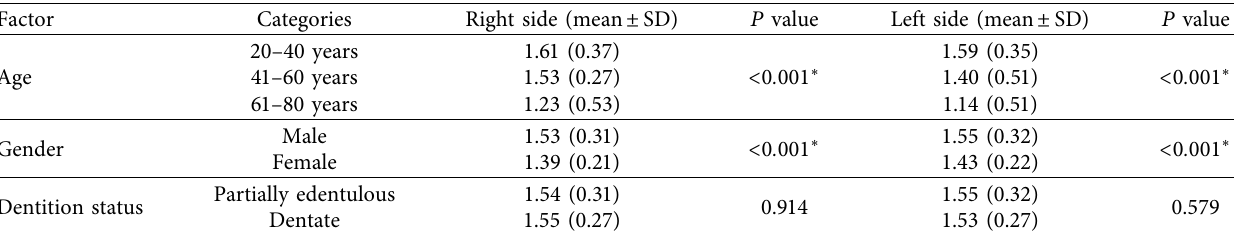
Table 5: Mean values of anterior extension of the alveolar loop on right and left sides according to age, gender, and dentition status.